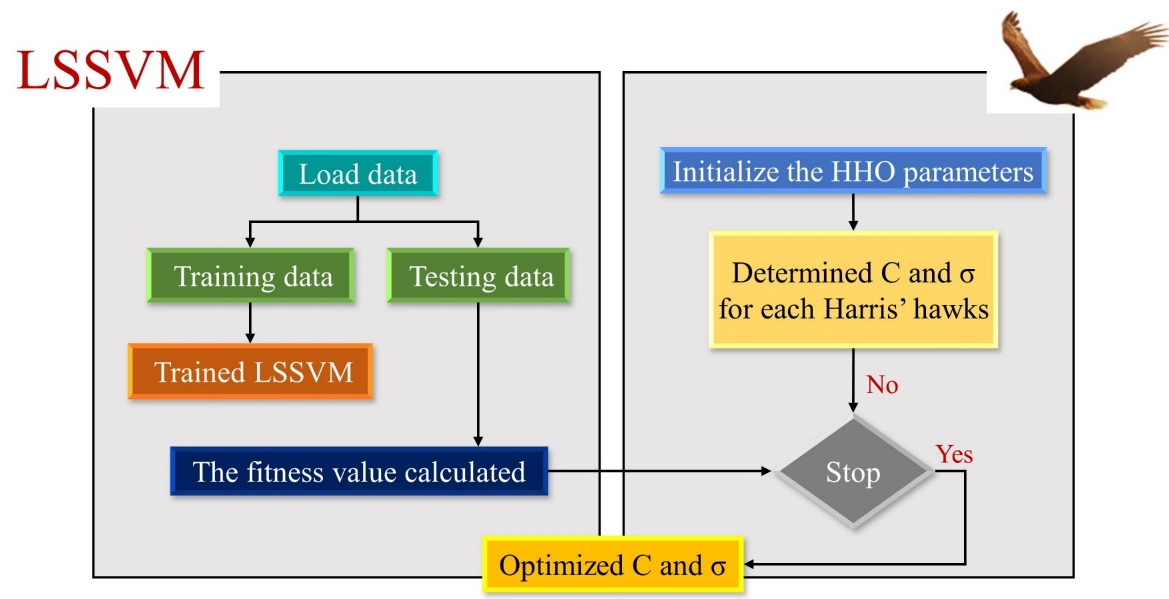
Figure 4. The schematic structure of the LSSVM-HHO.